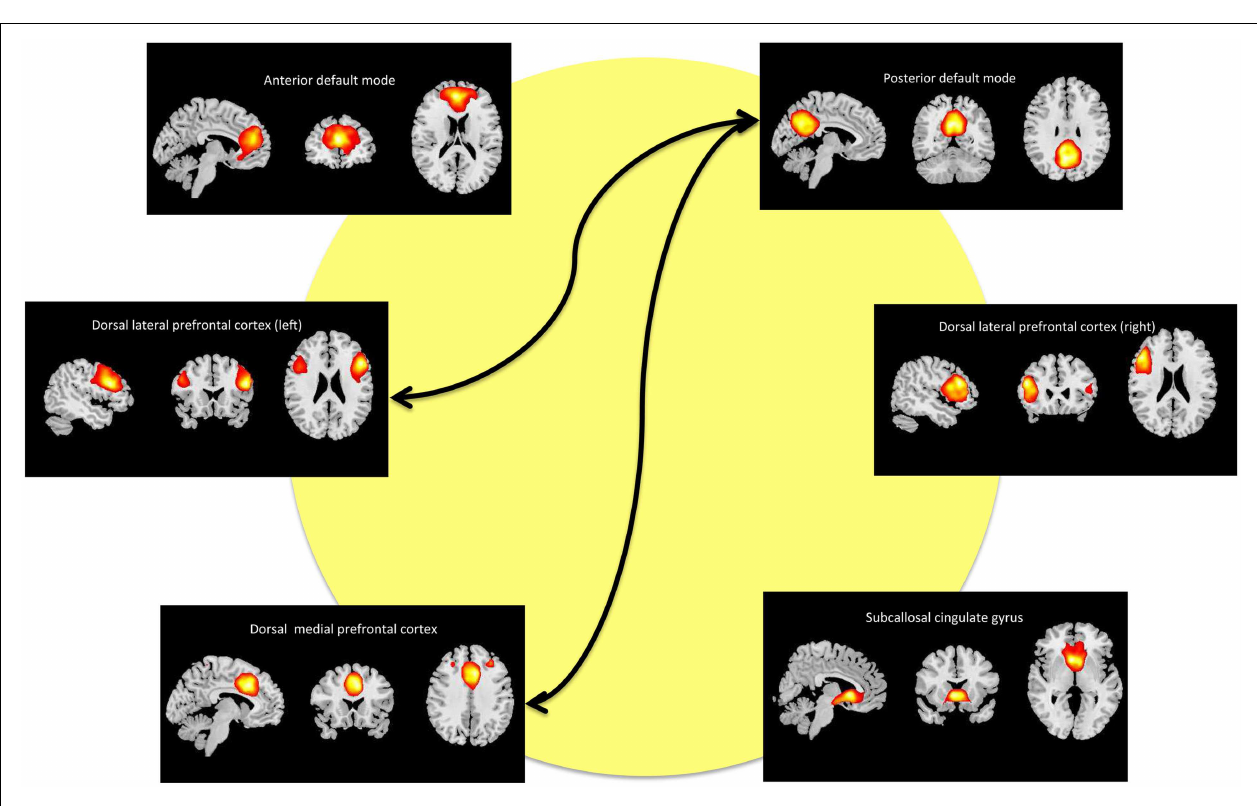
l_DPLFC). Each component map has a lower threshold of t = 10.The images are shown in radiological convention.The arrows represent the significant (FDR-corrected), longitudinal differences in FNC associated with ECT